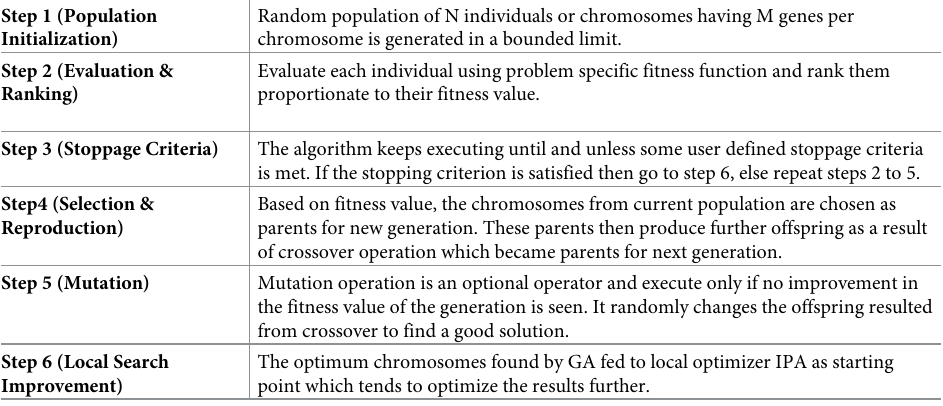
Table 1. Steps for hybridization of GA with